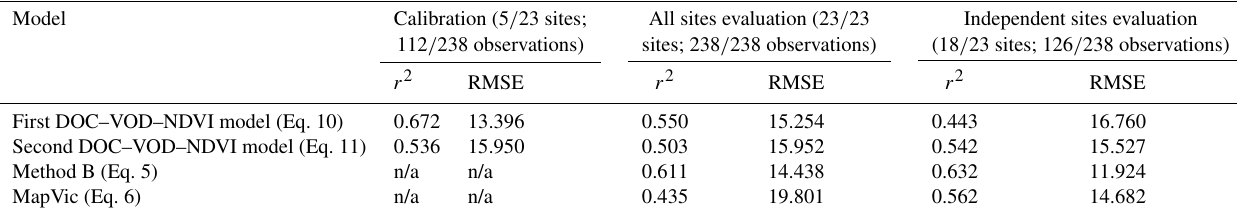
Table 1. Calibration and evaluation of satellite-based degree of curing (DOC) models derived from vegetation optical depth (VOD) and normalised difference vegetation index (NDVI). Evaluating existing estimated DOC models, Method B (Newnham et al., 2010) and MapVic (Martin et al., 2015), are also listed